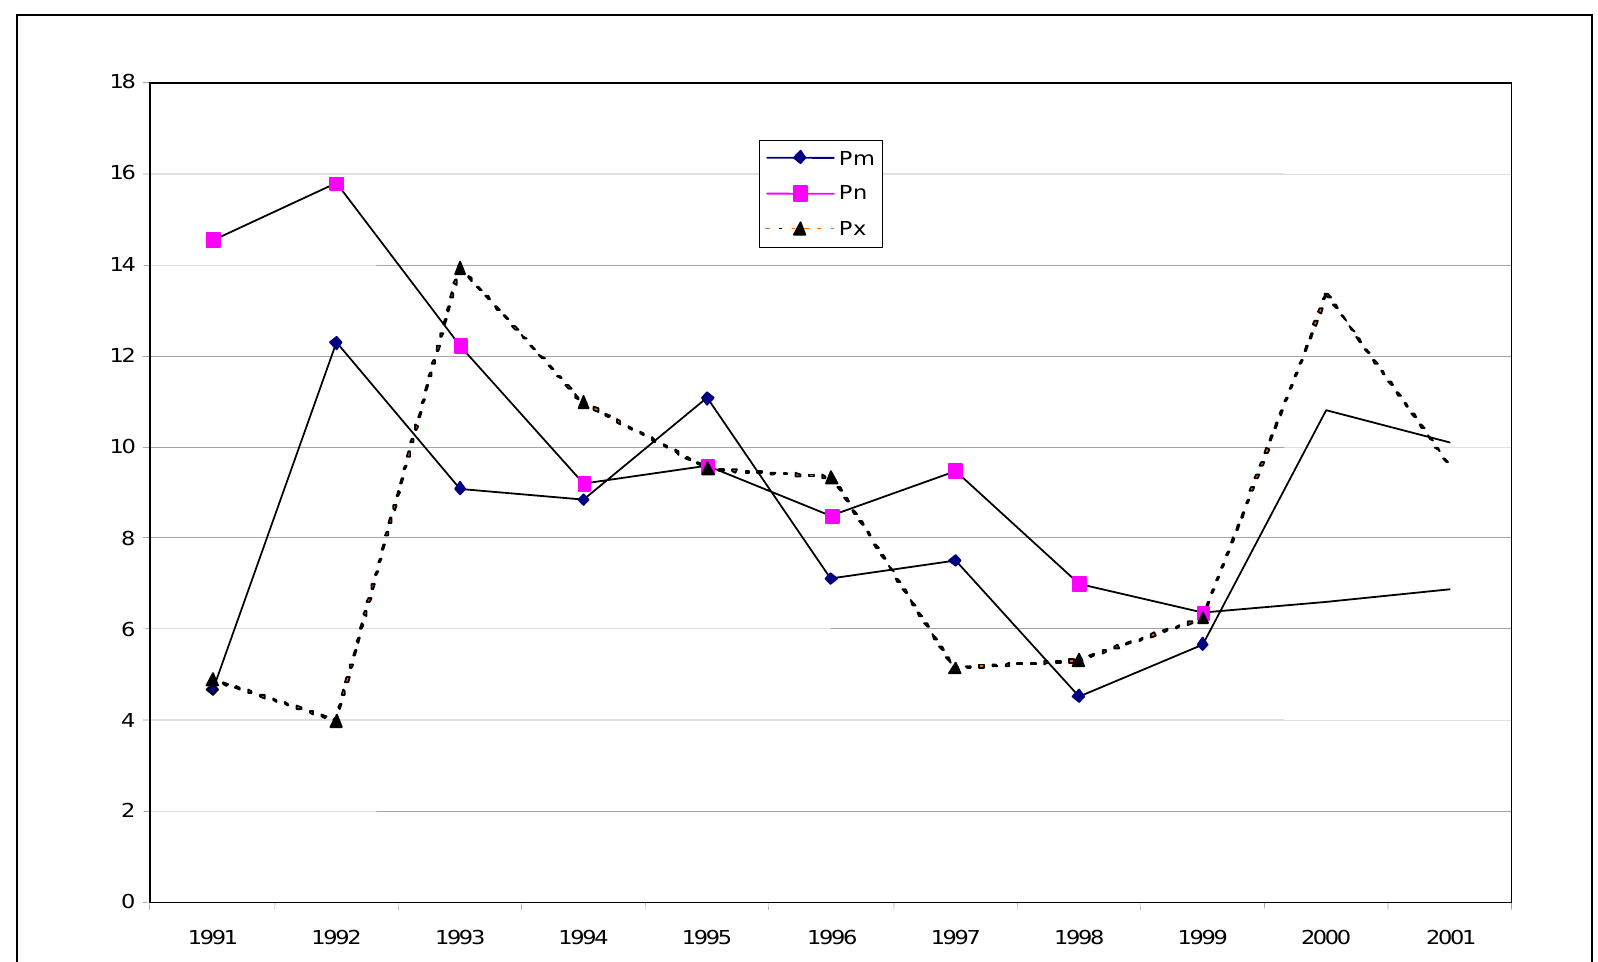
Figure 2 Growth rates of exportable, importable and non-tradable